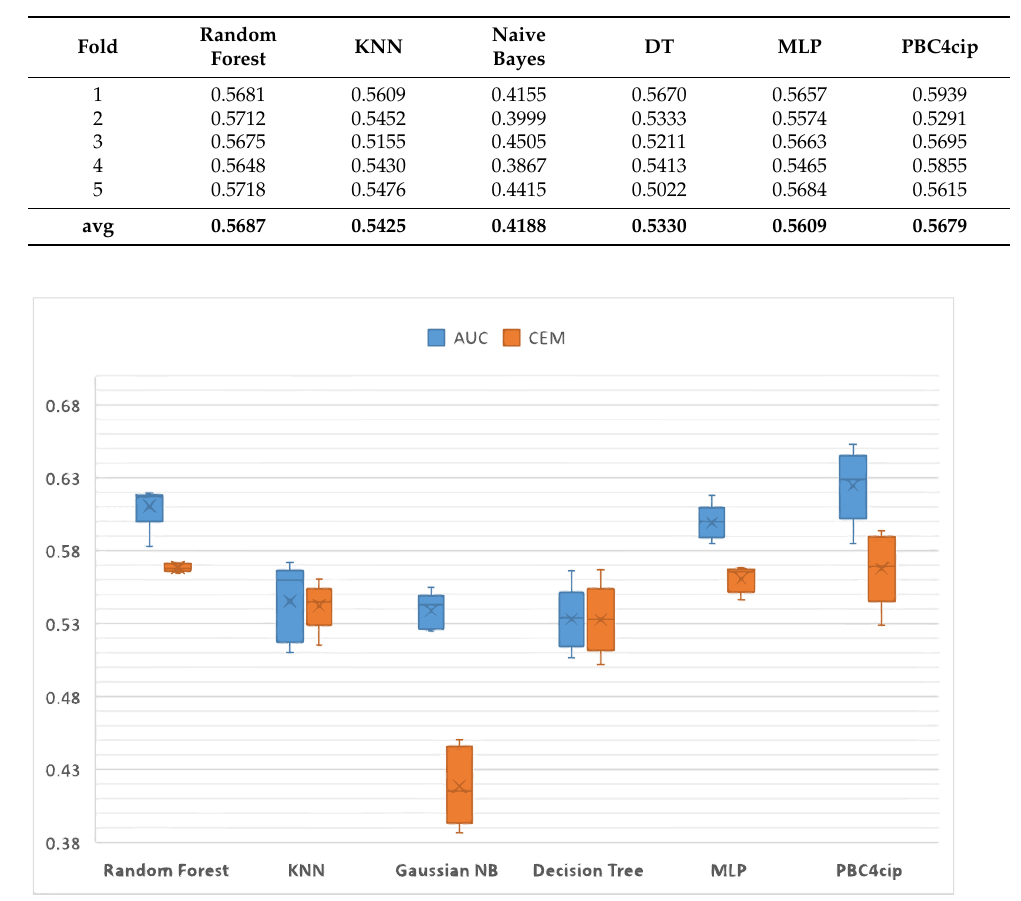
Figure 7. Metrics across the first phase of experimentation